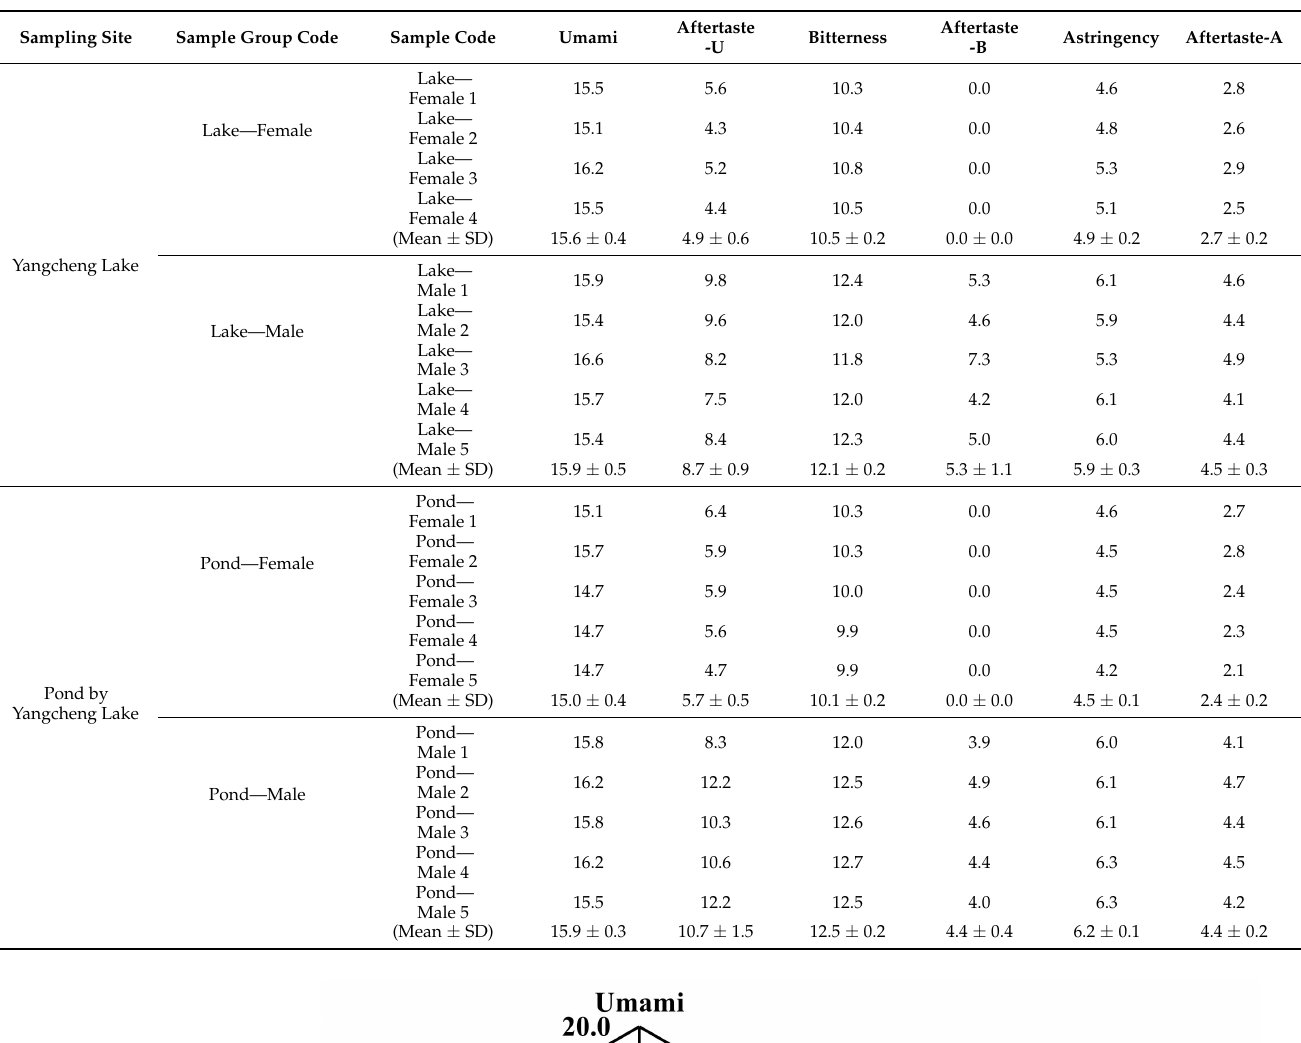
Table 1. Taste-active values of umami, aftertaste-U, bitterness, aftertaste-B, astringency, and aftertaste- A in the hepatopancreas of June hairy crab of Eriocheir sinensis from the net enclosure culture area in Yangcheng Lake and aquaculture ponds by the lake.